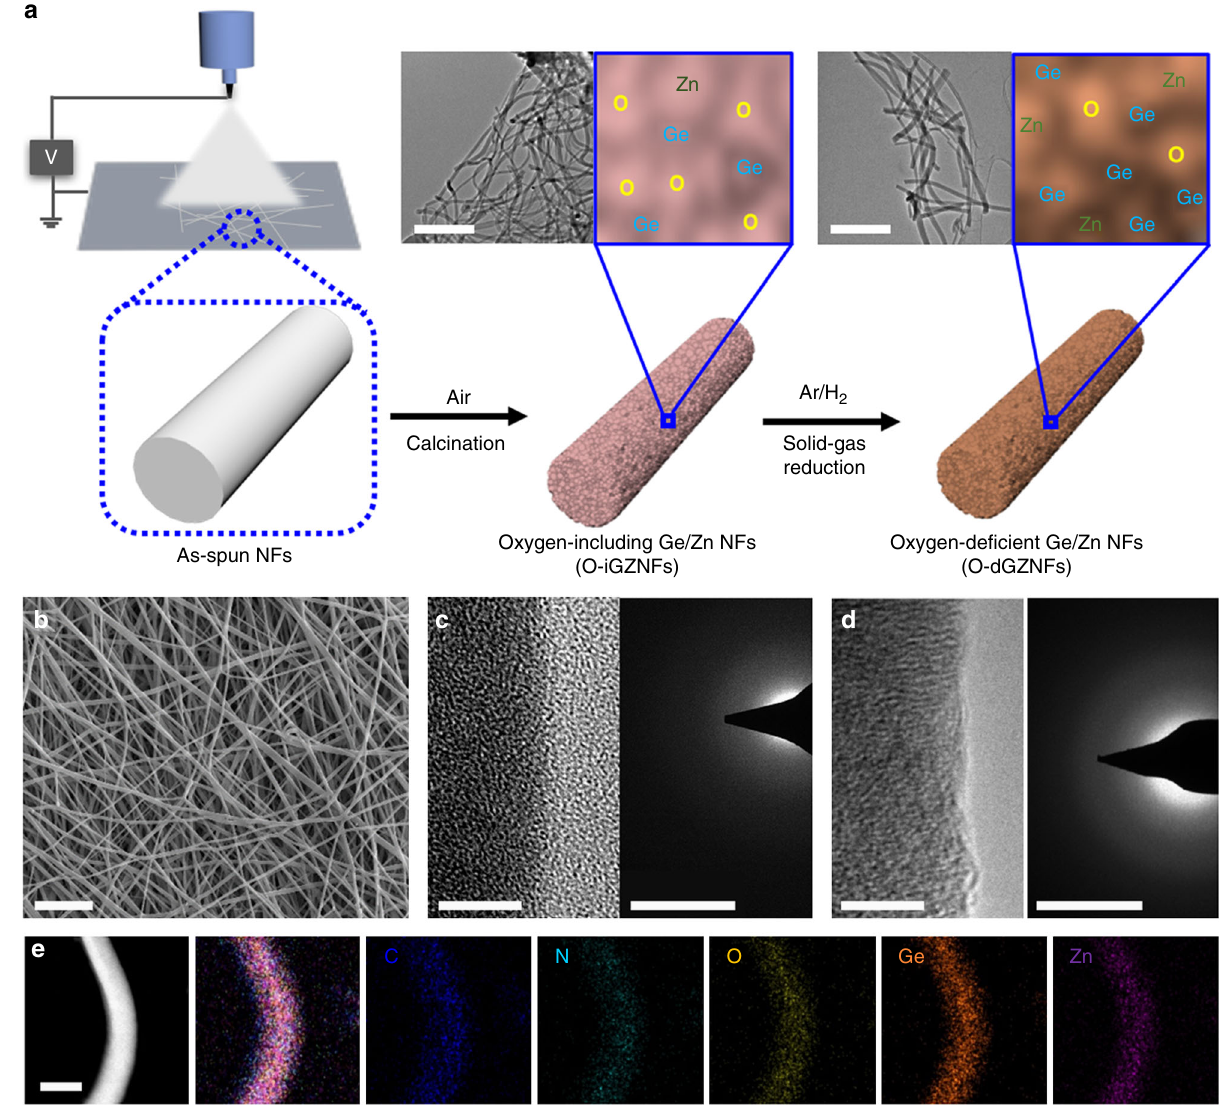
Fig. 1 Morphological structure evolution. a Schematic illustration of the whole synthetic process. The inset TEM images in a correspond to O-iGZNFs and O-dGZNFs. b SEM image of as-spun NFs. HR-TEM images and SAED patterns of c O-iGZNFs and d O-dGZNFs. e HAADF-STEM mapping of O-dGZNFs: red — carbon, orange — nitrogen, yellow — oxygen, cyan — germanium, and green — zinc. Scale bars: a 500 nm, b 10 μ m, c , d 5 nm and 5 1/nm, and e